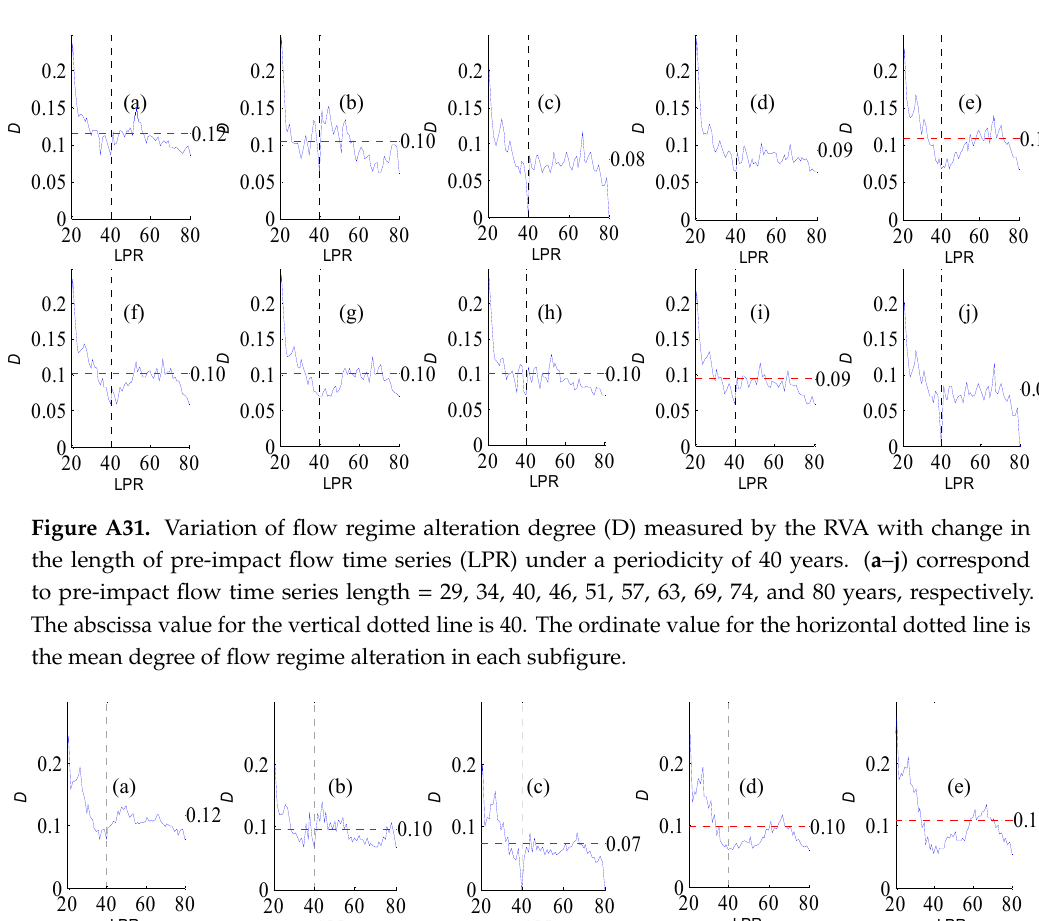
Figure A30. Variation of flow regime alteration degree (D) measured by the RVA with change in the length of post-impact flow time series (LPR) under a periodicity of 39 years. ( a ), ( b ), ( c ), ( d ), ( e ), ( f ), ( g ), ( h ), ( i ), and ( j ) correspond to pre-impact flow time series length = 28, 33, 39, 45, 50, 56, 61, 67, 72, and 78 years, respectively. The abscissa value for the vertical dotted line is 39. The ordinate value for the horizontal dotted line is the mean degree of flow regime alteration in each subfigure.